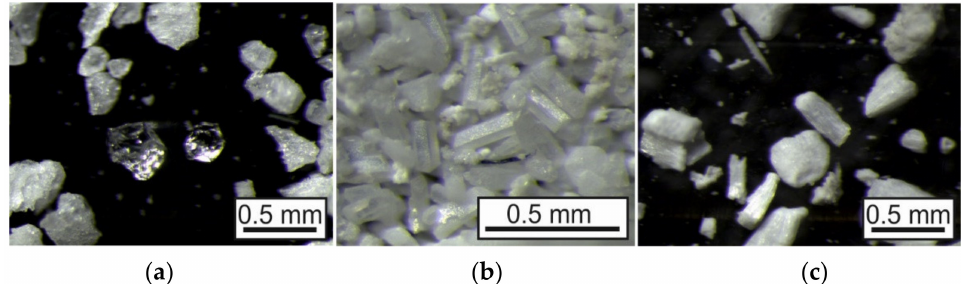
Figure 17. Various crystals obtained by the hybrid gel technique with a sparingly soluble reagent. ( a ) Crystals of churchite-(Y); ( b ) Crystals of anglesite; ( c ) Fibrous crystals of